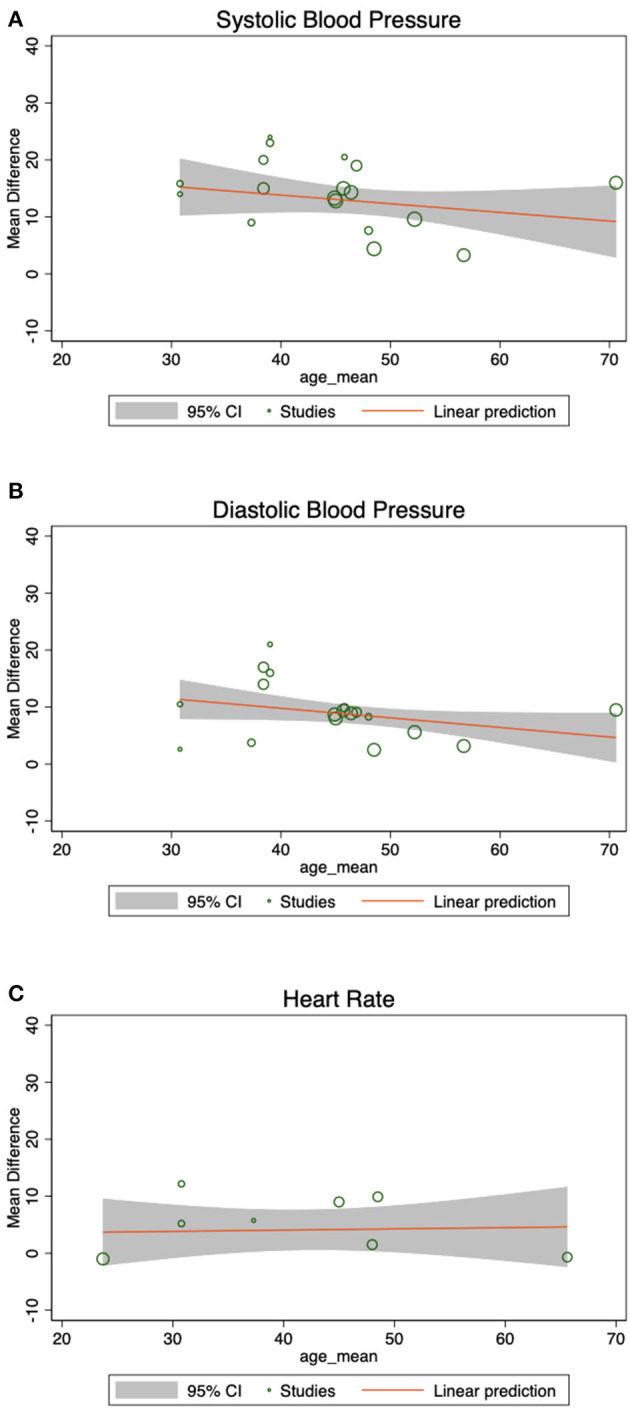
Meta-regression by age. These weighted scatter plots display hemodynamic data and its relationship with age, given by the meta-regression coefficient, showing that the association between mean age and (A) SBP, (B) DBP, and (C) HR was not statistically significant.